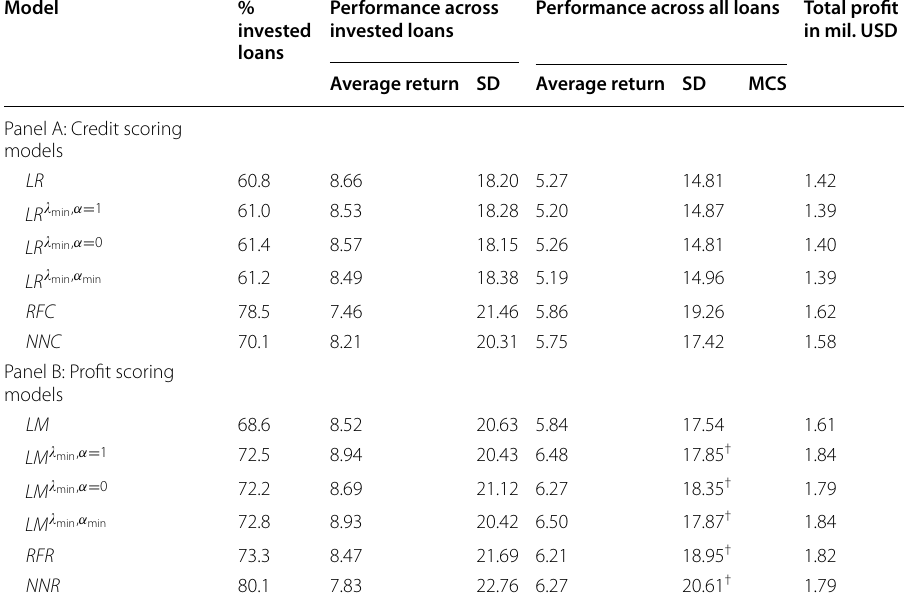
LR (cid:31) min , α = 1 , LR (cid:31) min , α = 0 , LR (cid:31) min , α min are lasso, ridge and elastic net version of logistic regression, LM (cid:31) min , α = 1 , LM (cid:31) min , α = 0 , LM (cid:31) min , α min are lasso, ridge and elastic net version of linear regression SD standard deviation, LR logistic regression‑based models, LM linear regression‑based models, RFC random forest classification, NNC neural network classification, RRR random forest regression, NNR neural network